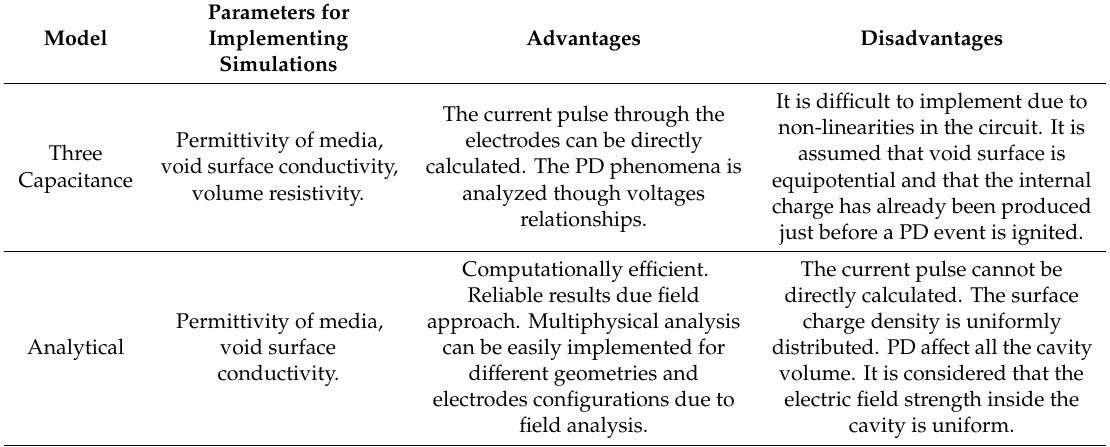
Table 6. Summary of main characteristics of analytical and three-capacitance model.